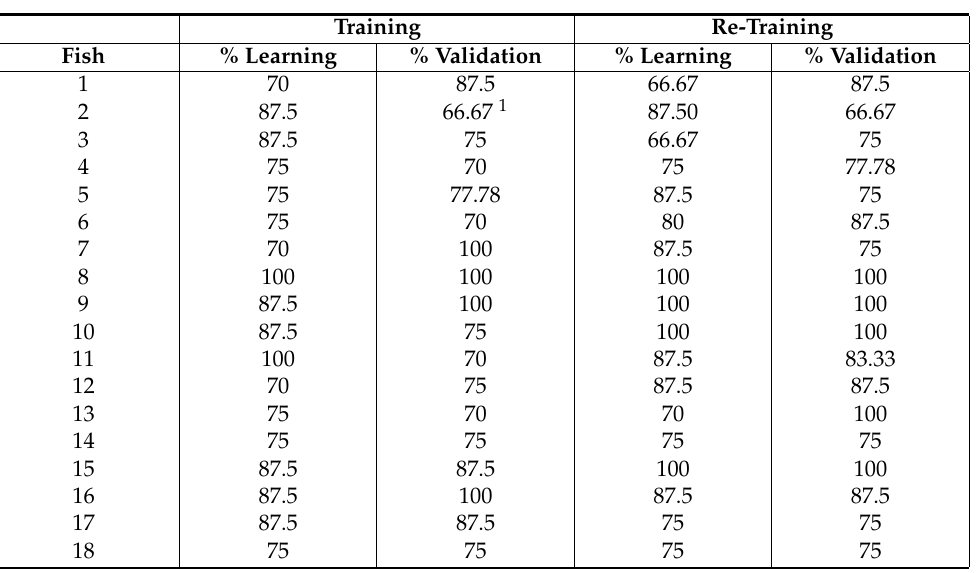
Table 1. First choices [%] in both the learning and validation sessions, for the phases of Training and